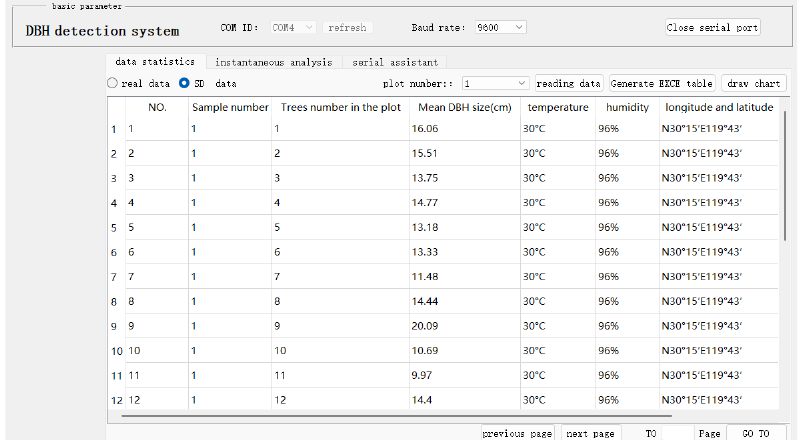
Figure 3. Schematic diagram of the host computer interface.